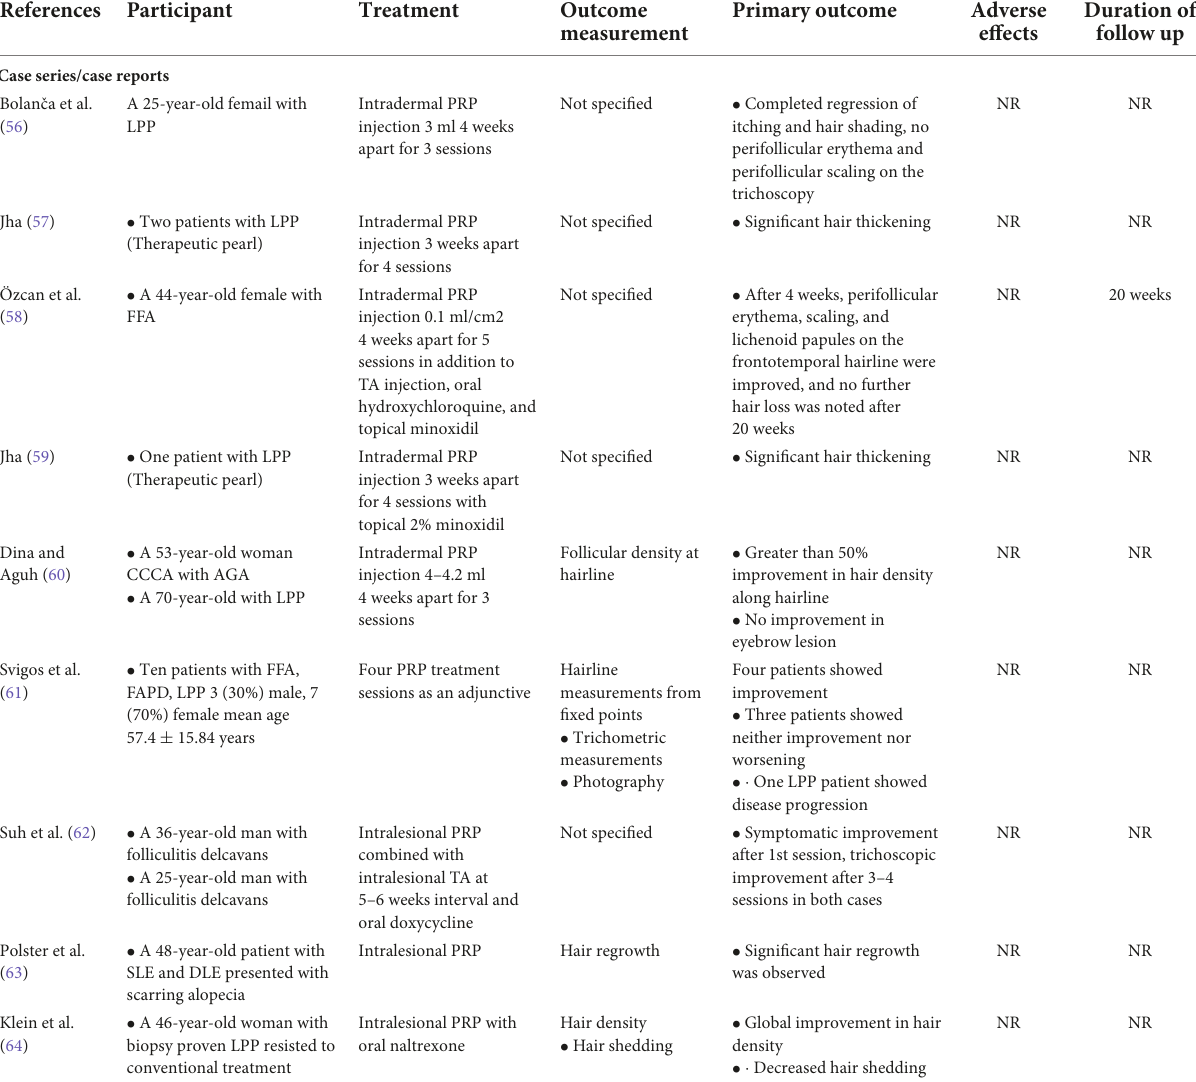
TABLE 2 Characteristics of primary cicatricial alopecia studies included in the systematic